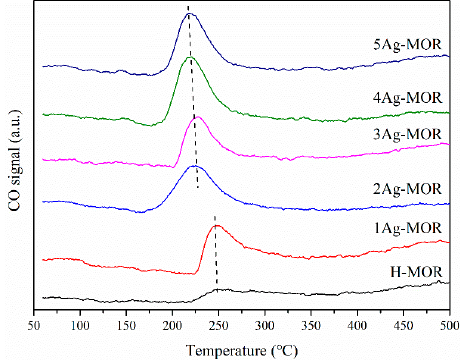
Figure 9. CO ‐ TPD spectra of the catalysts. Figure 9. CO-TPD spectra of the catalysts.